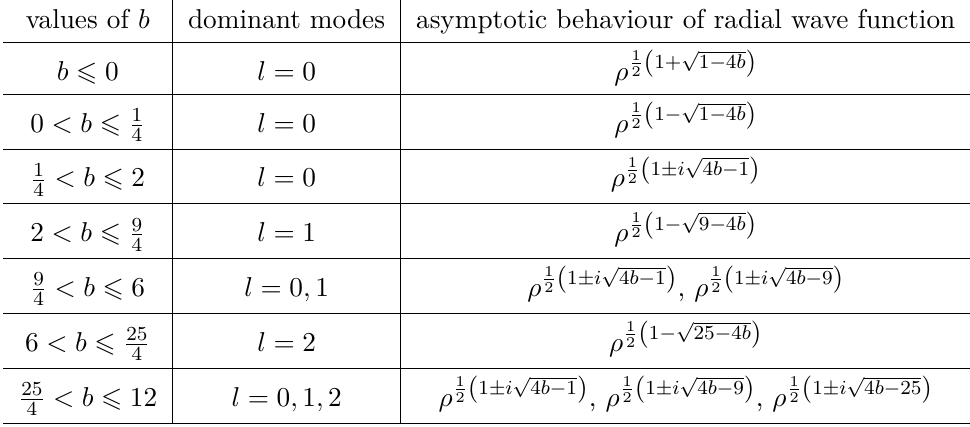
Table 1 . Some values of the coupling constant b for the transitional potential, along with the dominant modes at short ranges and the asymptotic behaviour of the radial wave function as ρ → 0 . For the purpose of illustration, we only list values of b no larger than